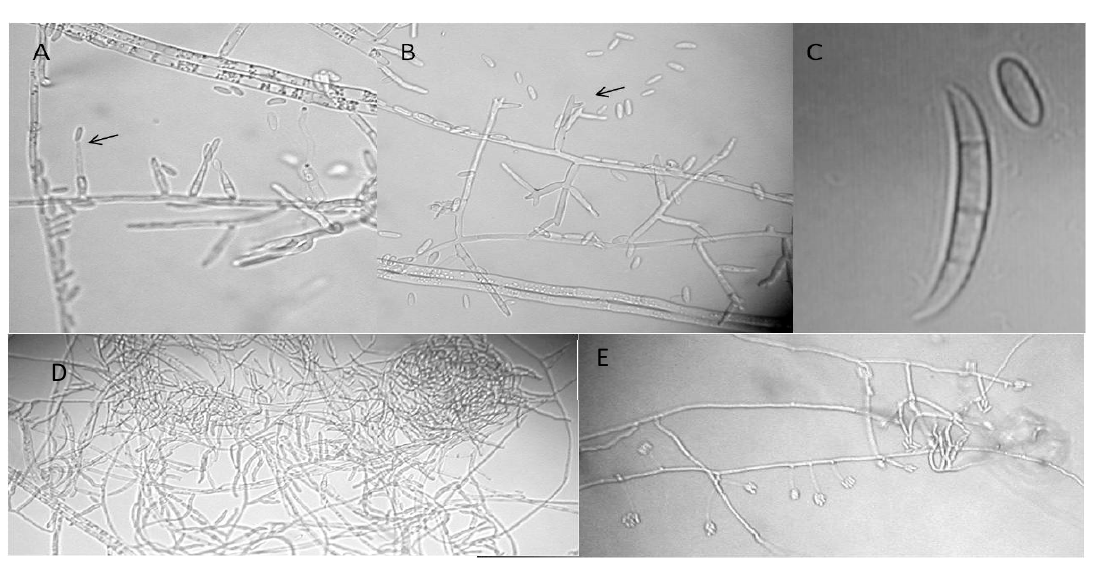
Figure 2. Morphological characters of F. circinatum ( A ) monophialides on Spezieller-Nährstoffarmer Agar (SNA) ( B ) polyphialides on SNA ( C ) micro- and macroconidium on Carnation Leaf Agar (CLA) (microconidia are also visible in a, b and e) ( D ) Fusarium circinatum coiled sterile hyphae on SNA ( E ) Fusarium circinatum microconidia growing in false heads on SNA. Spore sizes are given in the text.